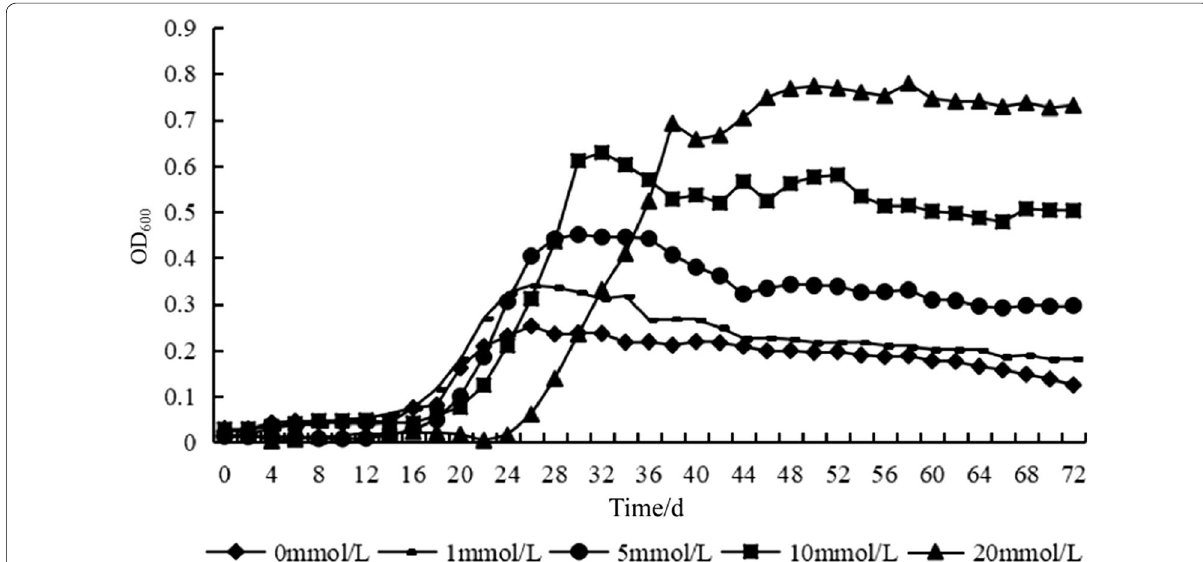
Fig. 1 G row th of Bur kho lderia multivo ran s WS‑ FJ9 in phosphate‑sol ubi liz i ng med ium with di ffe ren t exogenous s oluble phosphate concentrations